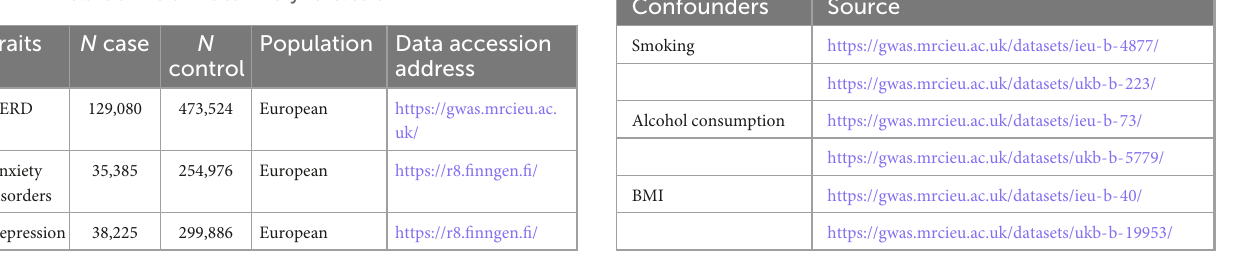
TABLE 1 Details of the GWAS summary-level data.